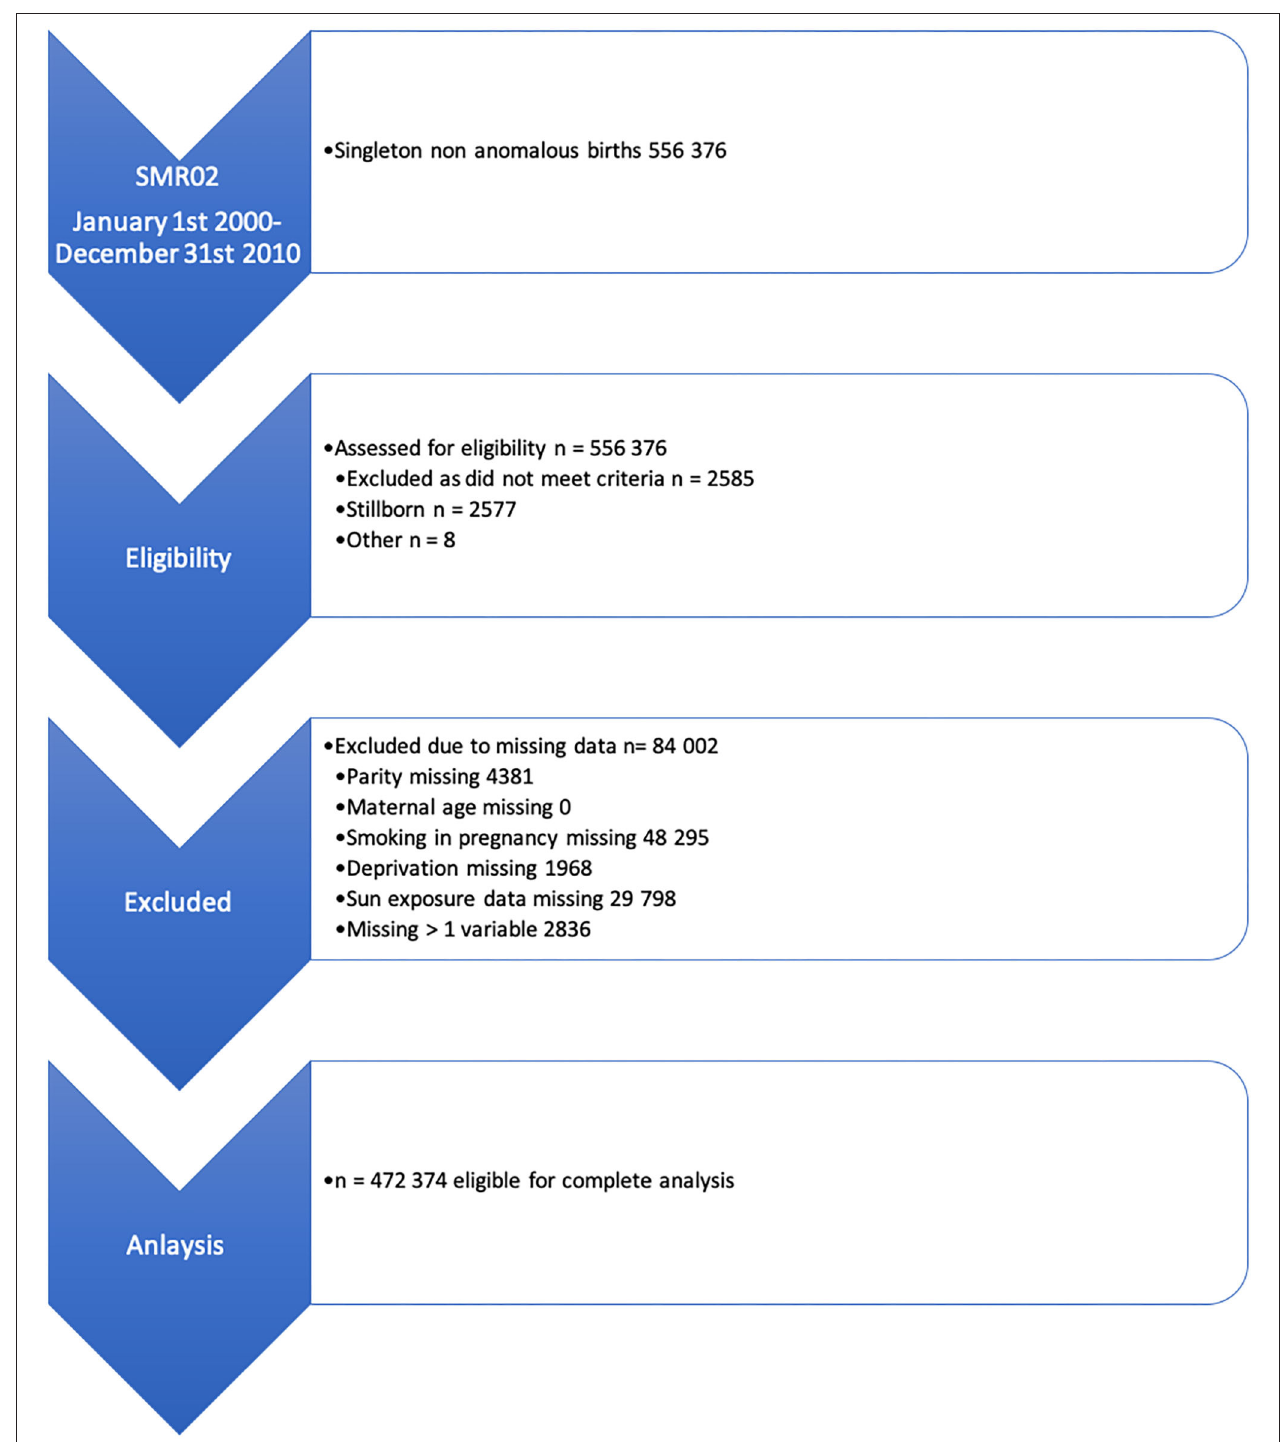
FIGURE 1 | Inclusion and exclusion flow chart for the study population.